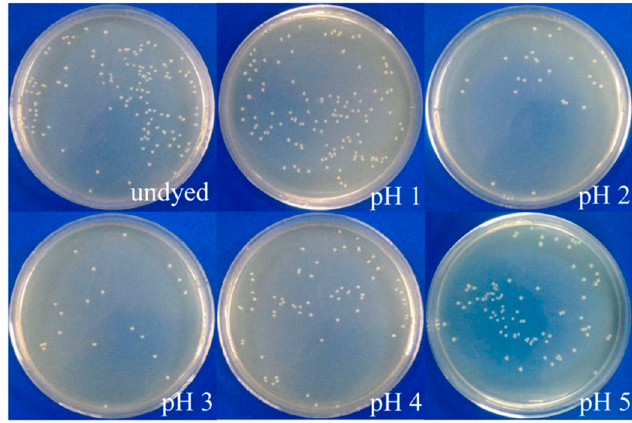
Figure 10. Antibacterial activity of cotton fabrics dyed under different pH values against E. coli .